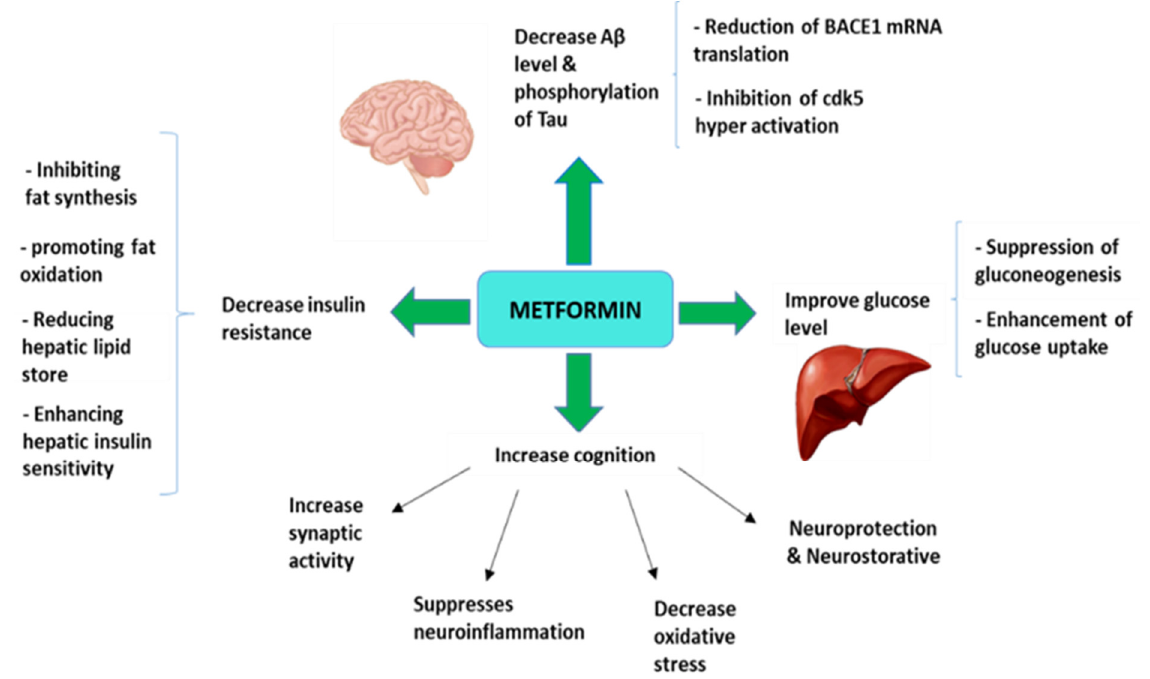
Figure 1. Metformin decreases the insulin resistance by multiple mechanisms and increases insulin sensitivity [18]. Reduction in level of A β and phosphorylation of Tau protein by reduction of BACE1 translation [67] and improving the glucose level by suppression of gluconeogenesis are the other beneficial effects of metformin treatment in neurodegenerative disorders such as AD [18]. Metformin also improves cognition by increasing synaptic activity [64,65,131], suppressing inflammation and decreasing oxidative stress [75]. In addition, metformin has neuroprotection and neurorestorative effects to increase memory, learning, and cognition in AD cases [101].